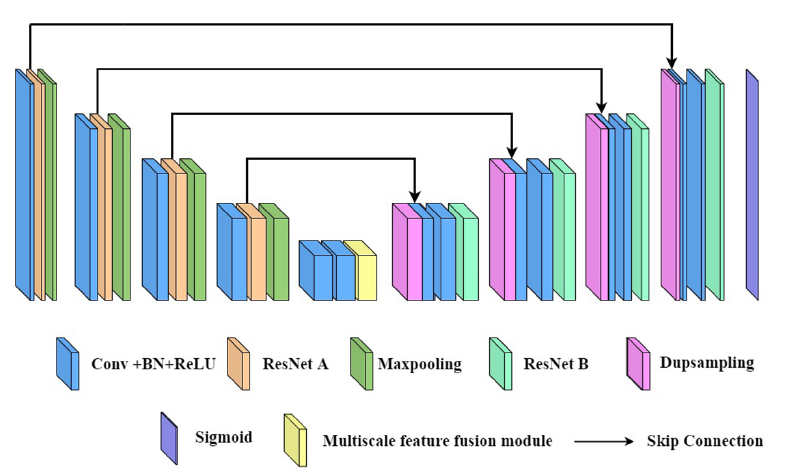
Figure 2. Structure diagram of L-Unet model; consists of downsampling, MFF module and